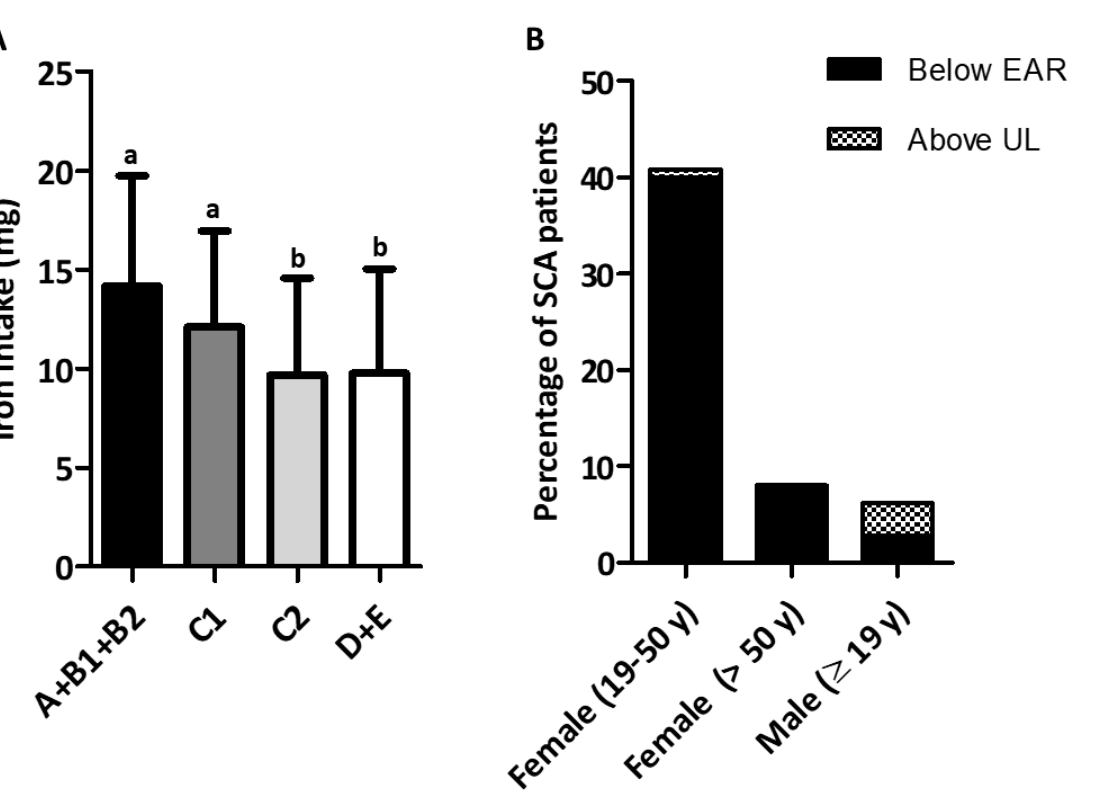
Figure 2. Iron intake of adults with sickle cell anemia. ( A ) Iron intake according to socioeconomic classification. Socioeconomic classes A ( n = 1) + B1 ( n = 2) + B2 ( n = 35); socioeconomic class C1 ( n = 70); socioeconomic class C2 ( n = 82); socioeconomic classes D–E ( n = 25). Values correspond to median iron intake of the respective classes. The same letters indicate no significant difference according to Mann–Whitney test. Nonparametric test for trend across ordered groups (nptrend) was performed ( p < 0.0001). ( B ) Prevalence of inadequate iron intake and relative intake of iron above upper limit. Estimated average requirement (EAR) for iron: 6 mg ( ≥ 19 years); 8.1 mg (19–50 years); 5 mg (>51 years); UL: tolerable upper limit of intake: >45 mg.